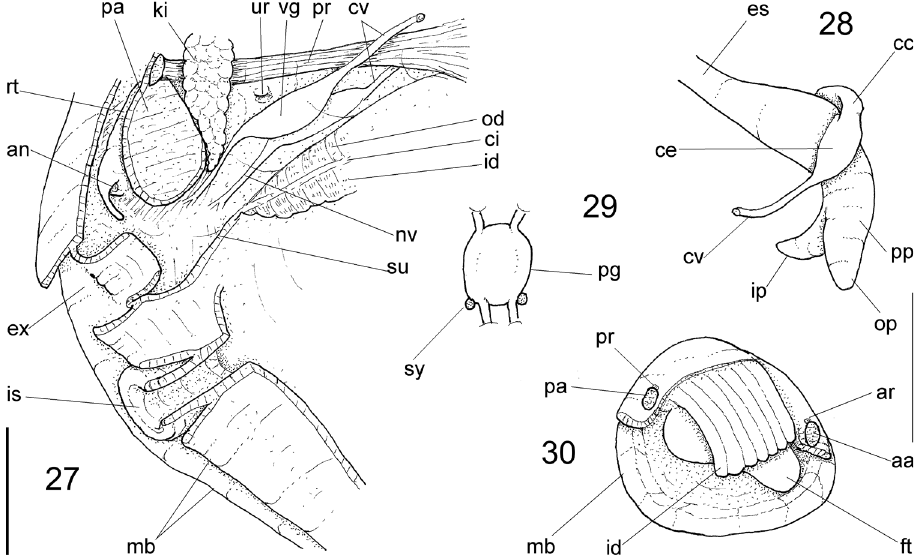
Figures 27–30. Eupera troglobia anatomical drawings 27 peri-siphonal, posterior region, right view, right gill and mantle lobe removed, siphons longitudinally sectioned, visceral structures seen as in situ 28 transition between palps and esophagus, right view, with concern to cerebral ganglia 29 pedal ganglia, dorsal view 30 gross anatomy of young specimen from gill brood pouch, right view, right mantle lobe removed. Scale bars: 0.5